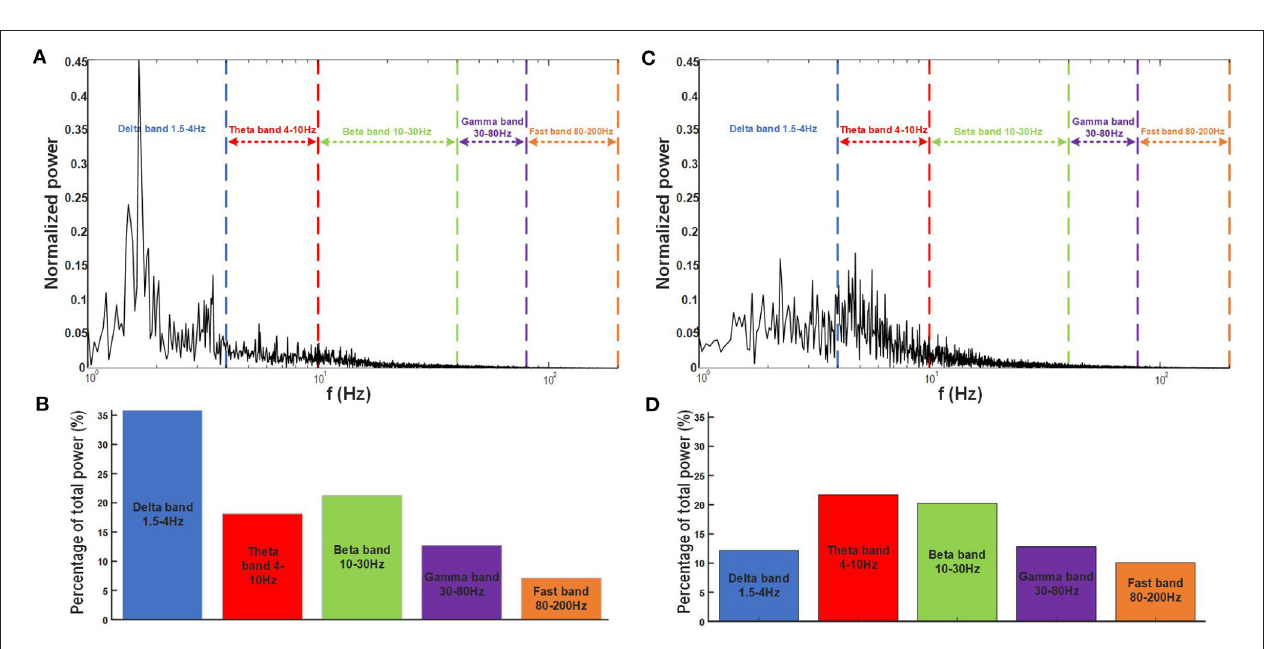
FIGURE 9 | (A) Frequency content for a 30 s LFP recording on one electrode of the 16 electrode implant in the primary motor cotex of the Long-Evans rat under anesthesia with the traditional frequency bands used for analysis identified on the graph. (B) Power percentage contained in each band for the specific recording in anesthesia. (C) Frequency content for a 20 s LFP recording on the same electrode as in (A) , a week after implantation while the rat is freely moving with the traditional frequency bands used for analysis identified on the graph. (D) Power percentage contained in each band for the specific recording for the freely moving